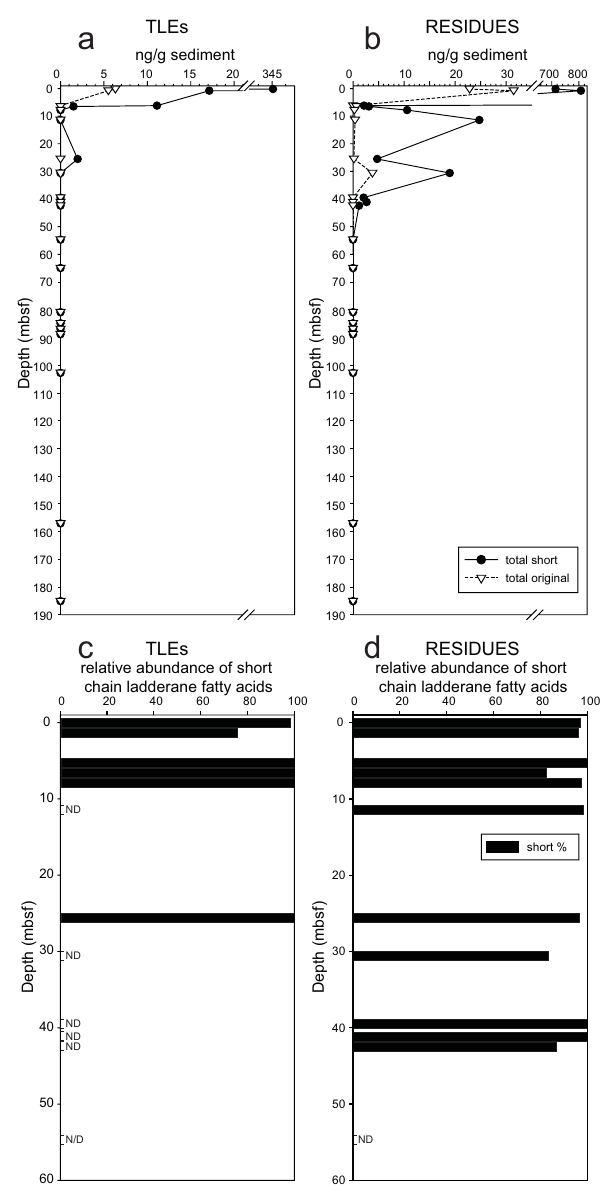
Fig. 7. Peru Margin (ODP Leg 201 – Site 1229) depth profile of deep sediment core. Freely extractable ladderane fatty acids (to- tal lipid extracts – TLEs) and matrix-bound ladderane fatty